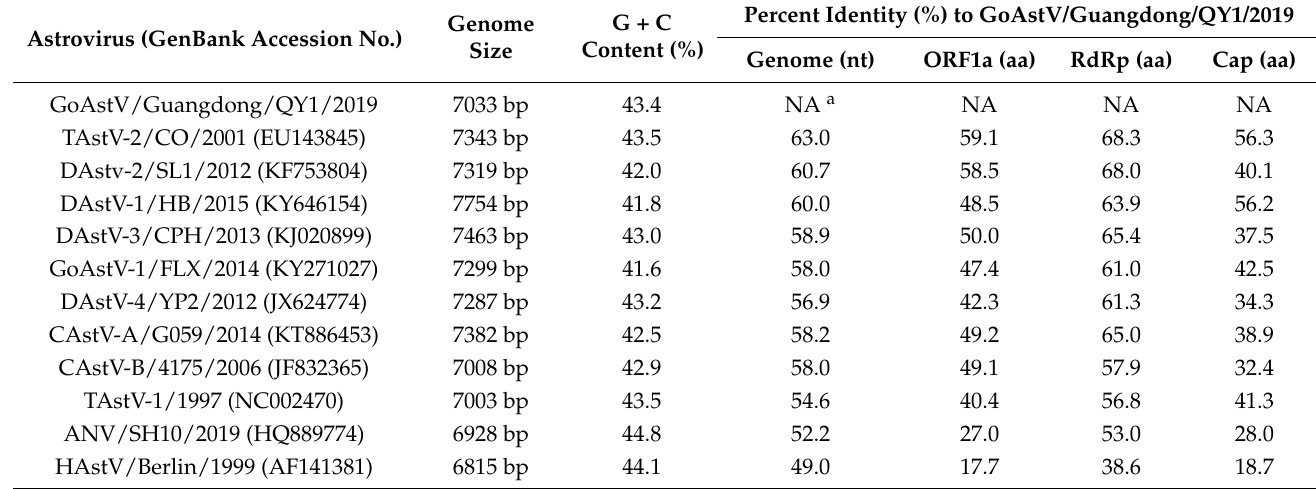
Table 2. Comparison of the GoAstV with other known AstVs based on the genome nucleotide and amino acid sequences of the ORF1a, RdRp and Cap